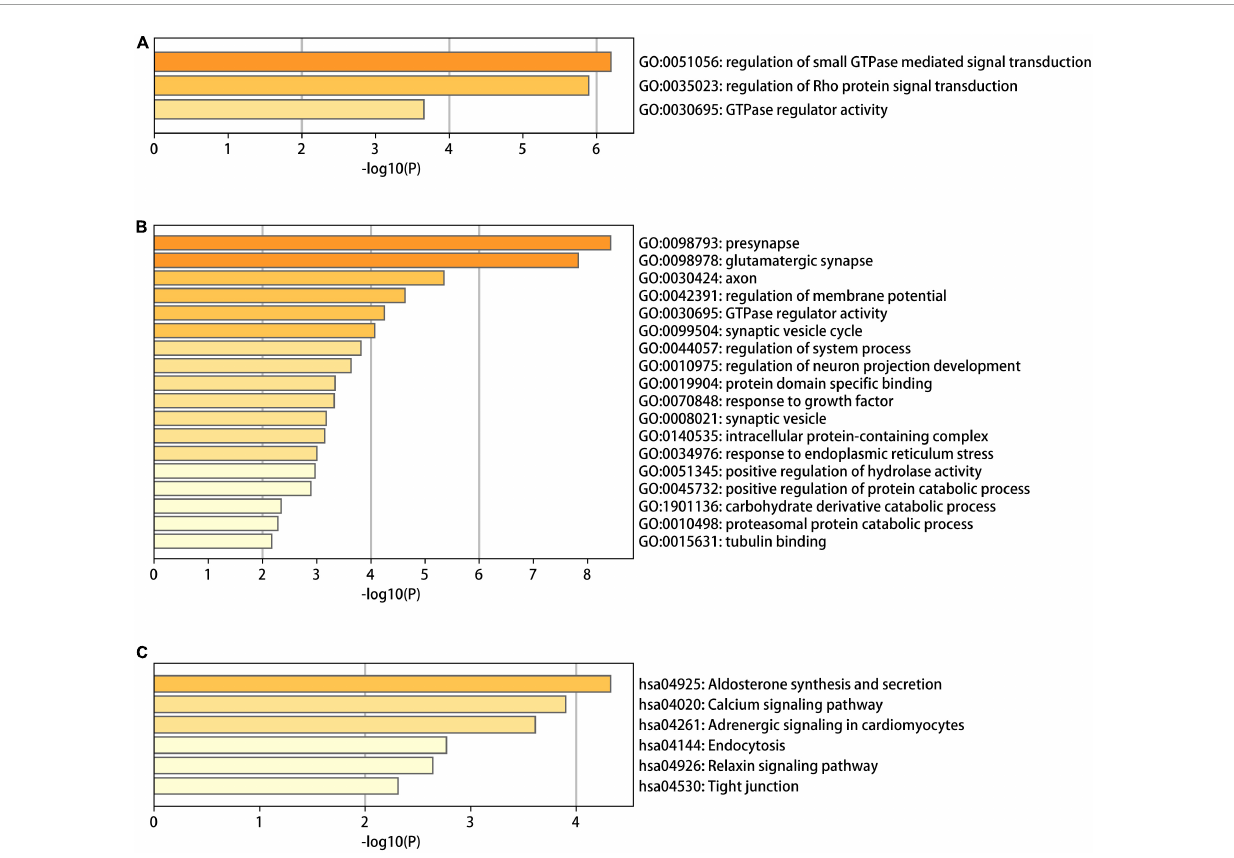
FIGURE5 The gene ontology (GO) and Kyoto encyclopedia of genes and genomes (KEGG) functional enrichment analysis results for differentially methylated genes in Alzheimer’s disease (AD). (A) The GO terms in the eight hypo-LGs of AD; (B,C) the GO and KEGG terms in the 61 hyper-LGs of